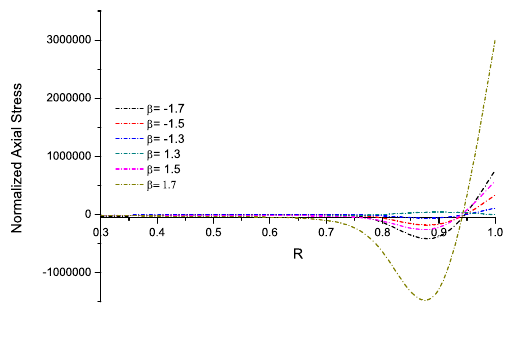
Figure 5: Normalized axial stress and radial coordinate for different values of β